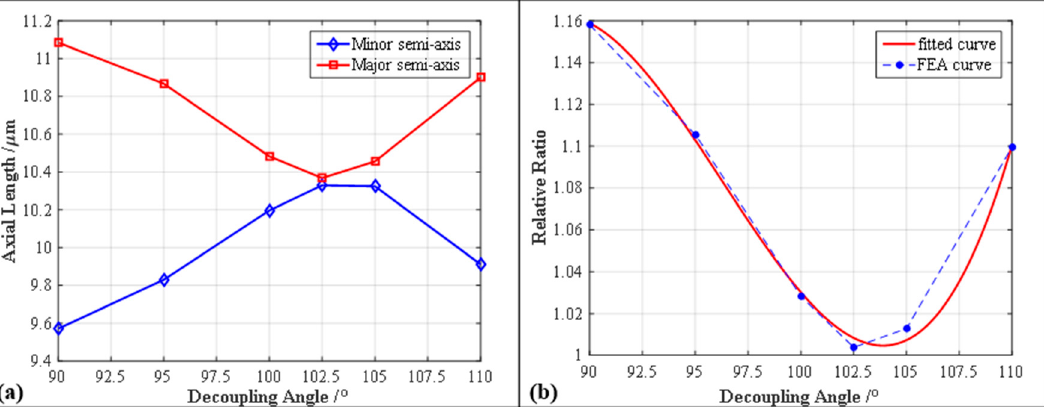
Figure 5. The influences of the PDCM’s decoupling angle Θ on the elliptical parameters and relative ratio. ( a ) Axial length a and b vs. decoupling angle Θ ; ( b ) Aspect ratio λ vs. decoupling angle Θ .